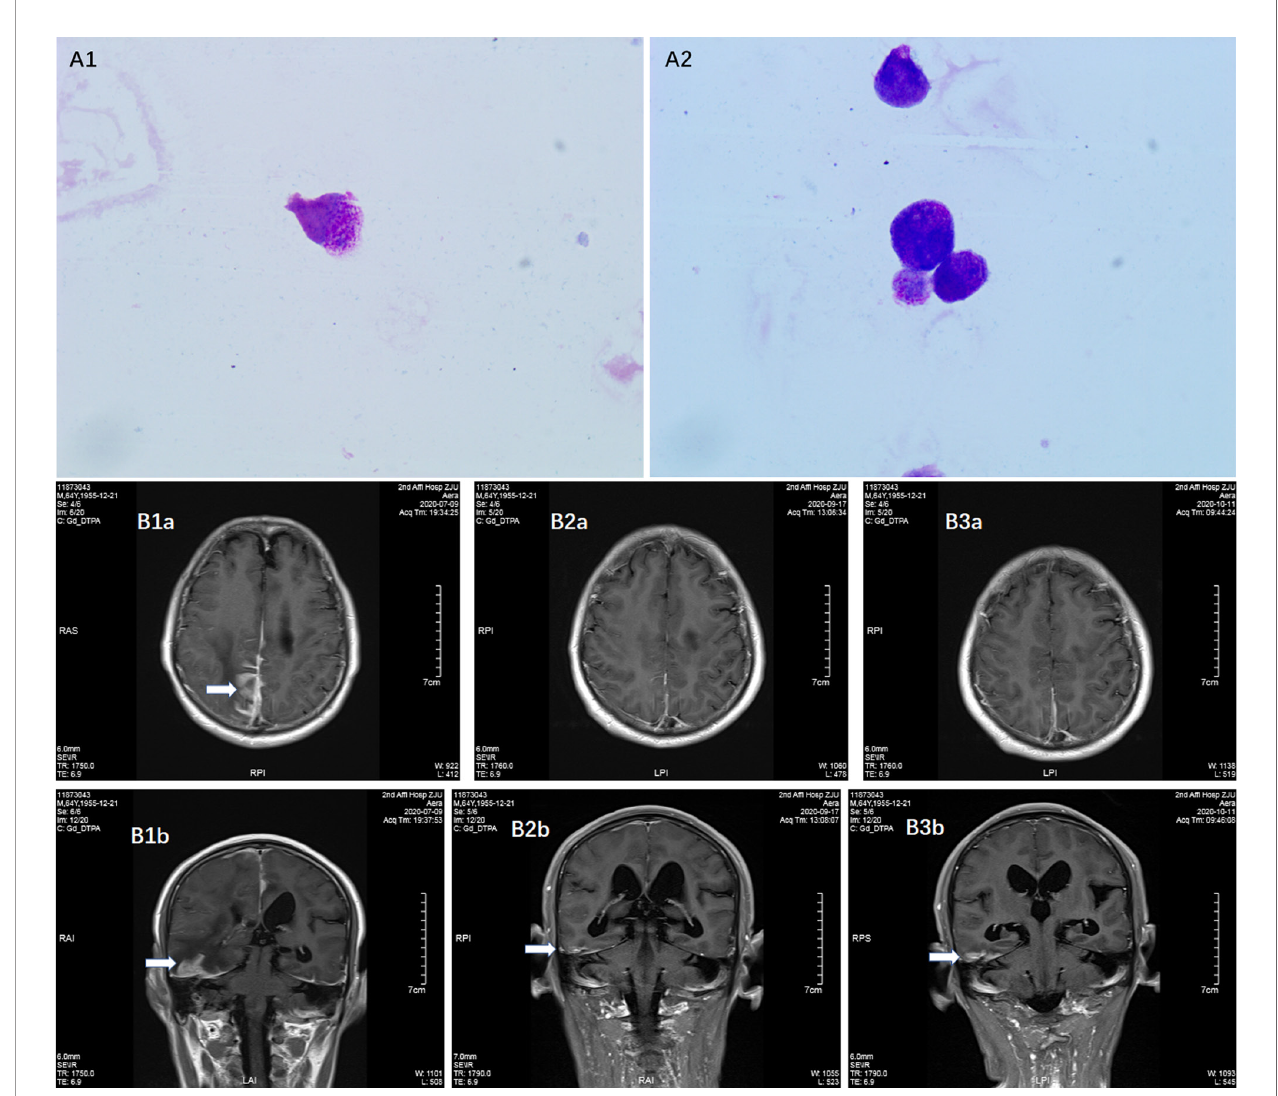
FIGURE 1 | Detection of meningeal involvement by APL cells. (A1 – 2) Promyelocytic leukemia cells in CSF; (B1a, 1b) Contrast MRI before venetoclax treatment on July 9, 2020, (B2a, 2b) Contrast MRI during venetoclax treatment on September 17, 2020; (B3a, 3b) Contrast MRI during venetoclax treatment on November 11,